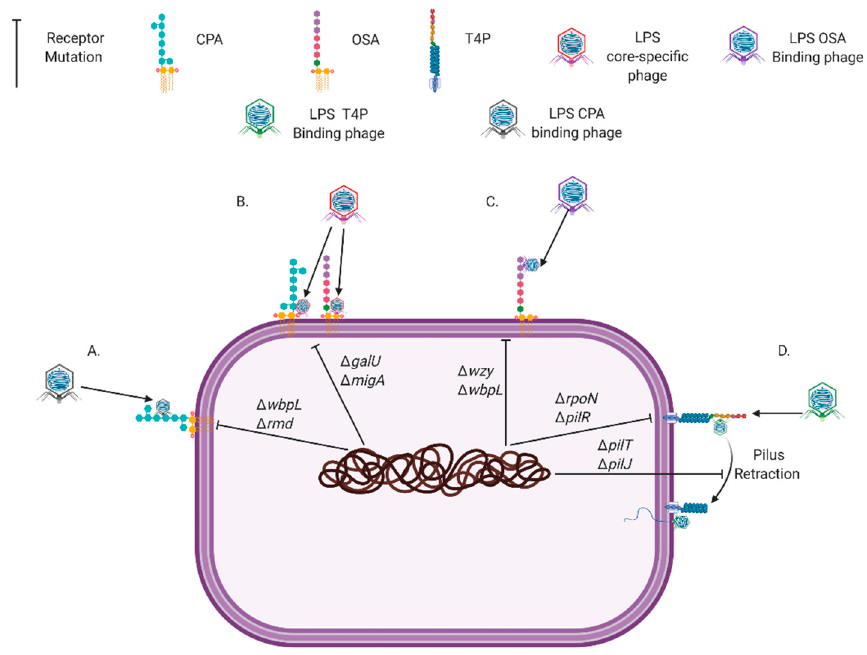
Figure 1. Common Pseudomonas aeruginosa genetic mutations that prevent the phage receptors Common Polysaccharide Antigen (CPA) ( A ), lipopolysaccharide (LPS) core ( B ), O-Specific Antigen (OSA) ( C ), and Type IV Pili (T4P) ( D ) being synthesized or functioning. Created with BioRender.com. The strength of both phage resistance and the associated fitness cost is phage-specific